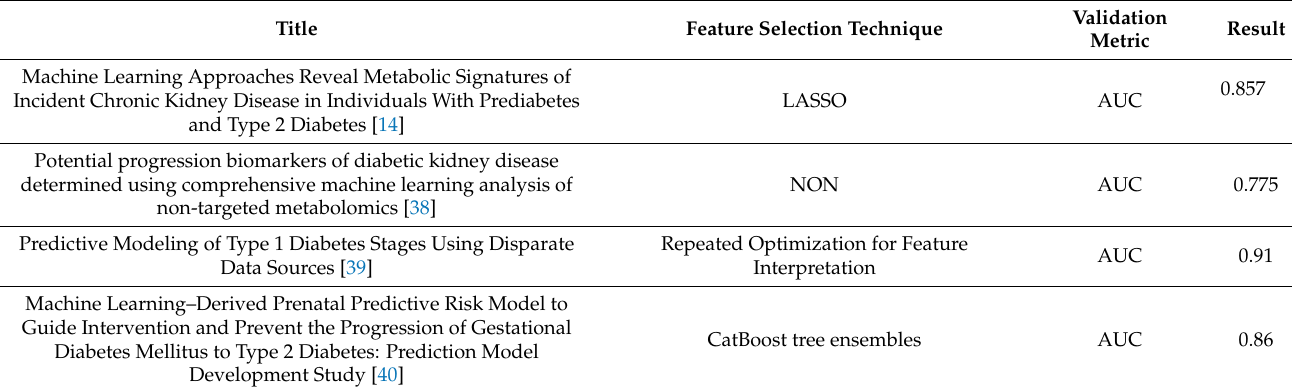
Table 16. Comparison of feature selection with related